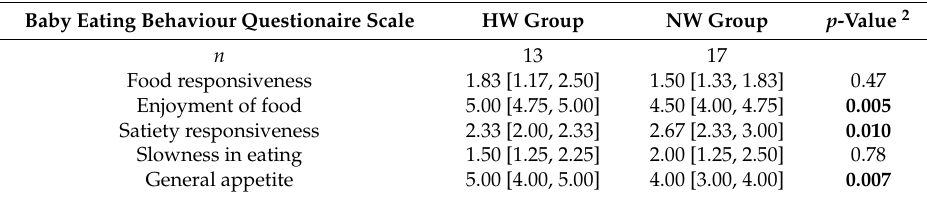
Table 5. Baby Eating Behaviour Questionaire at 5 months 1 .